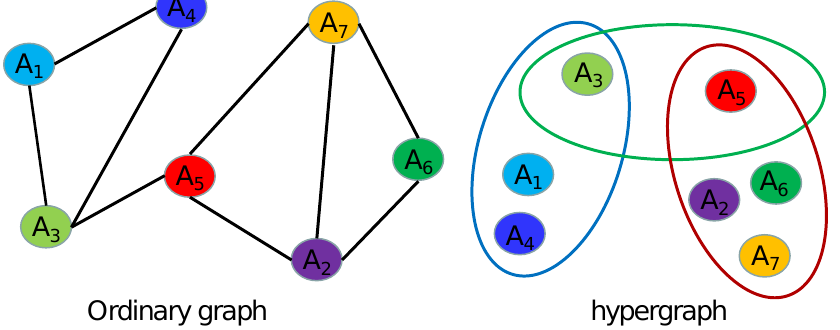
Figure 2. The structure comparison between ordinary graph and hypergraph of a cooperative network.